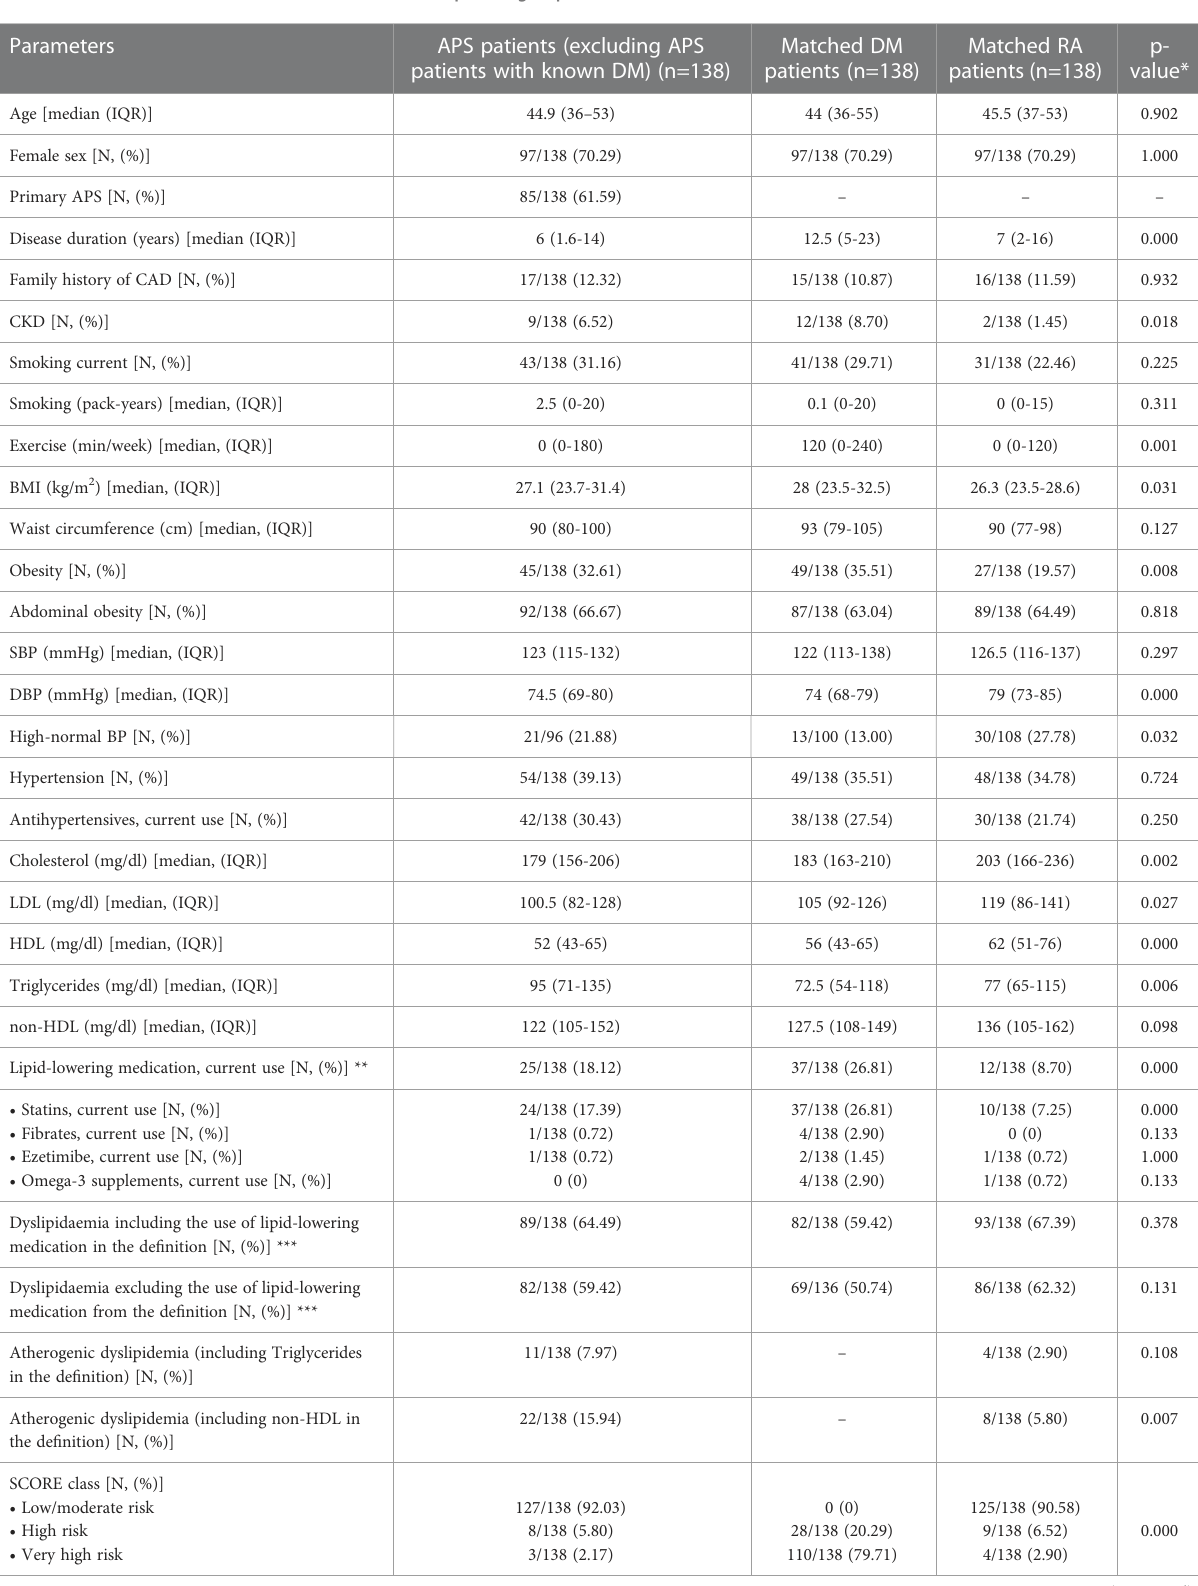
TABLE 1 Patient characteristics in the APS, RA and DM patient